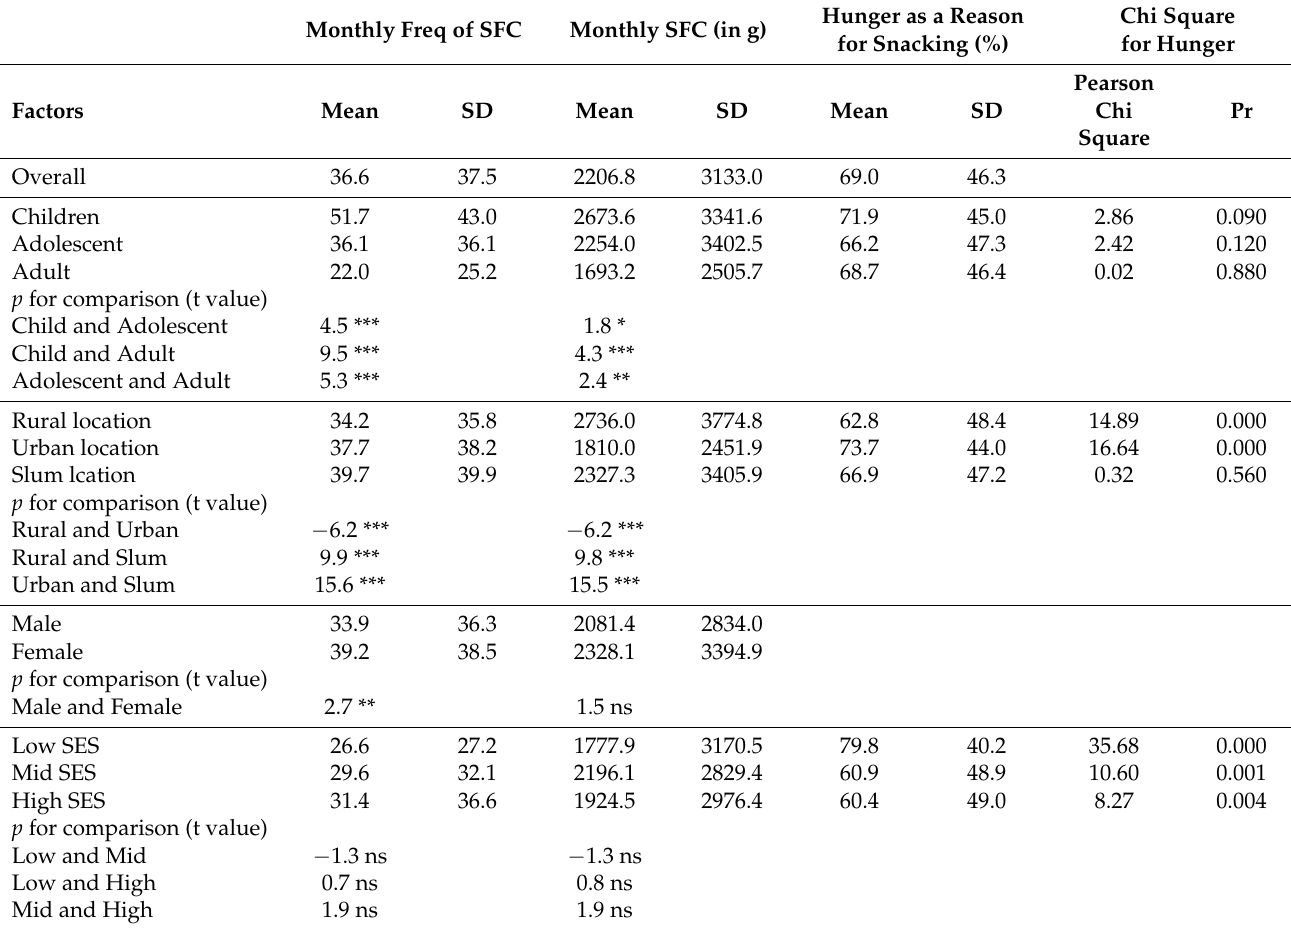
Table 1. Frequency and weight of SFC and incidence of hunger snacking. Monthly Freq of SFC Monthly SFC (in g)